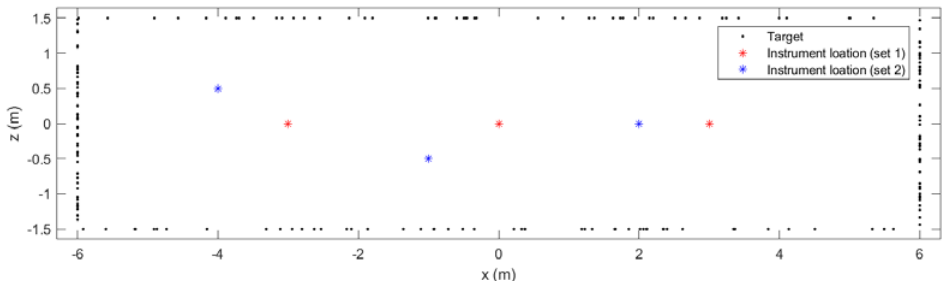
Figure 5. Simulated 2D target field and instrument locations.